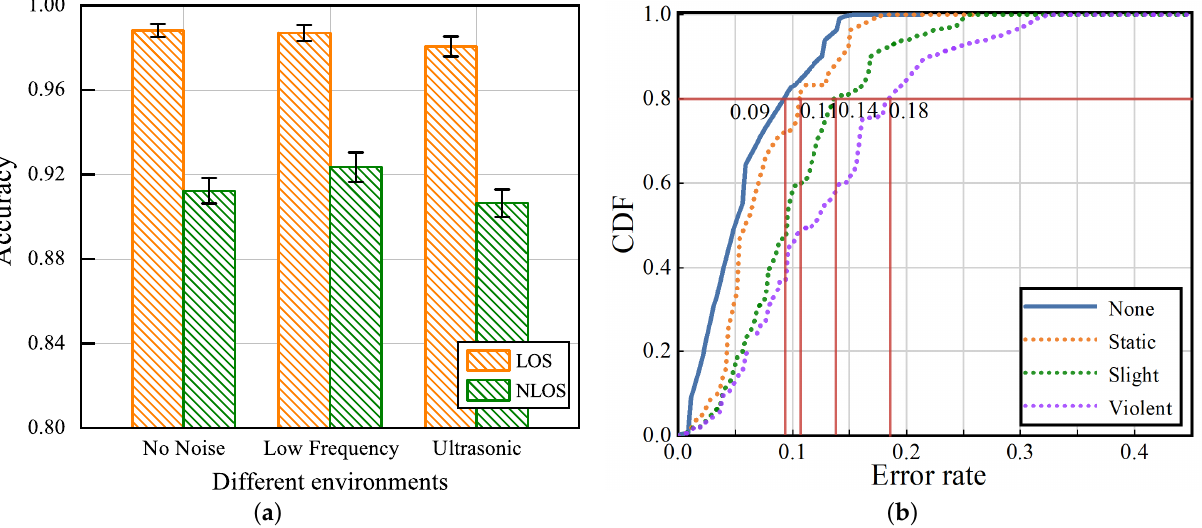
Figure 10. Impact of different environments and interference states. ( a ) Impact of different environ- ments and ( b ) impact of different interference